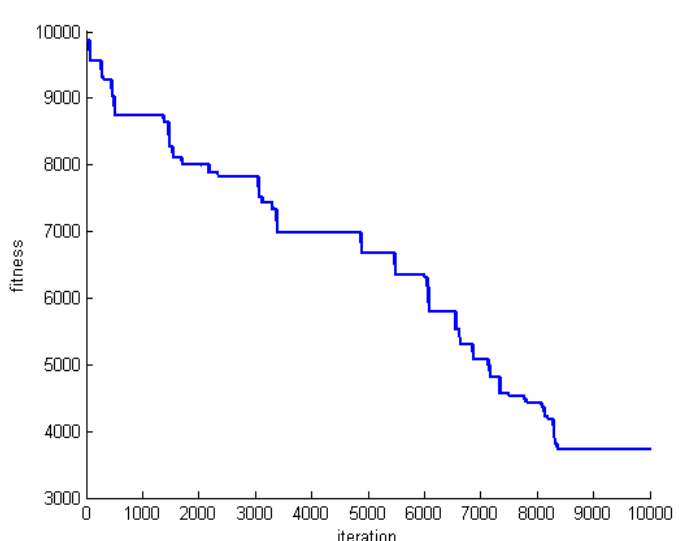
Figure 7. The fitness of the best whale during whales’ motion in DS 8 .